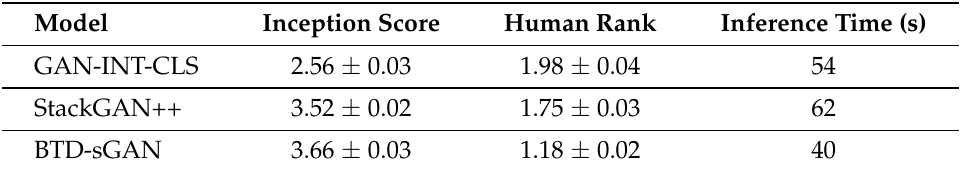
Figure 10. Three GAN generation results on the Oxford-102 flower dataset. At the same time, in numerical terms, “Inception Score”, “Human Rank”, and “In- ference Time” are used to compare the effects of different models. The performance comparison of different models is shown in Table 1. Table 1. Performance comparison of different models on the Oxford-102 dataset.